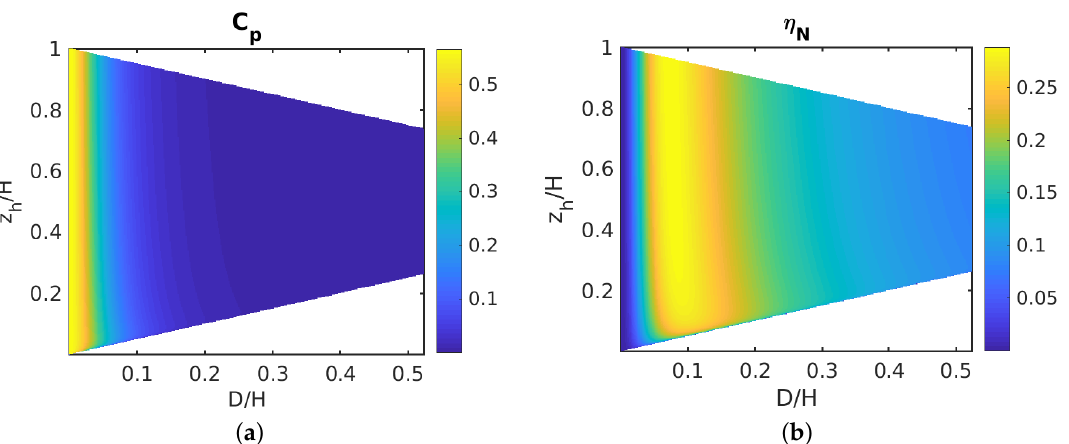
Figure 19. ( a ) Individual turbine power coefficient ( C P ) as a function of turbine diameter and tower height, with other parameters held fixed, predicted using Nishino’s model. ( b ) Wind farm power density ( η N ) as a function of turbine diameter and tower height, with other parameters held fixed, predicted using Nishino’s